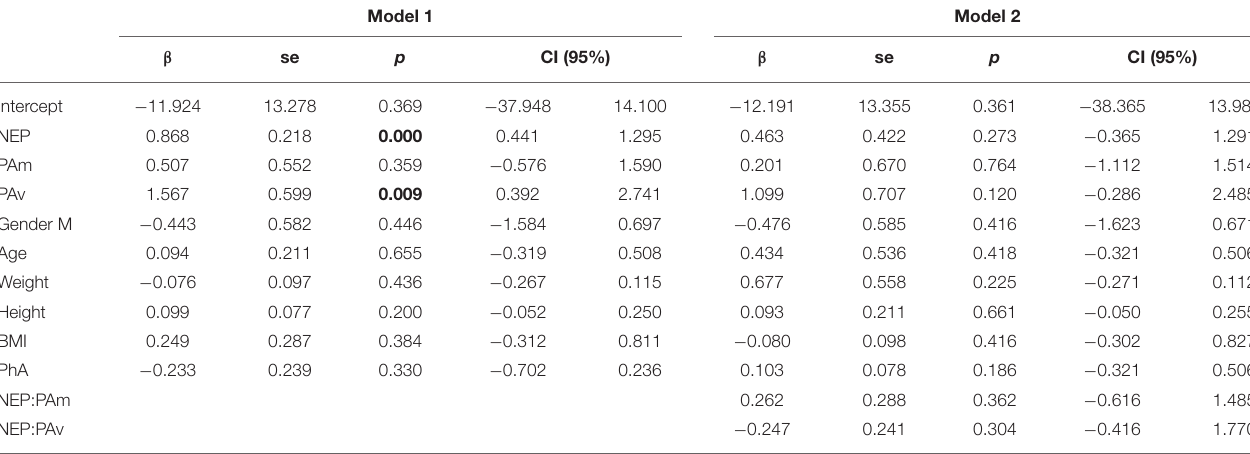
TABLE 2 | Mixed-effect linear regression model for the association between KIDMED score and NEP, PA, and a set of anthropometric parameters, considering T0 and T1 as a unique longitudinal dataset.